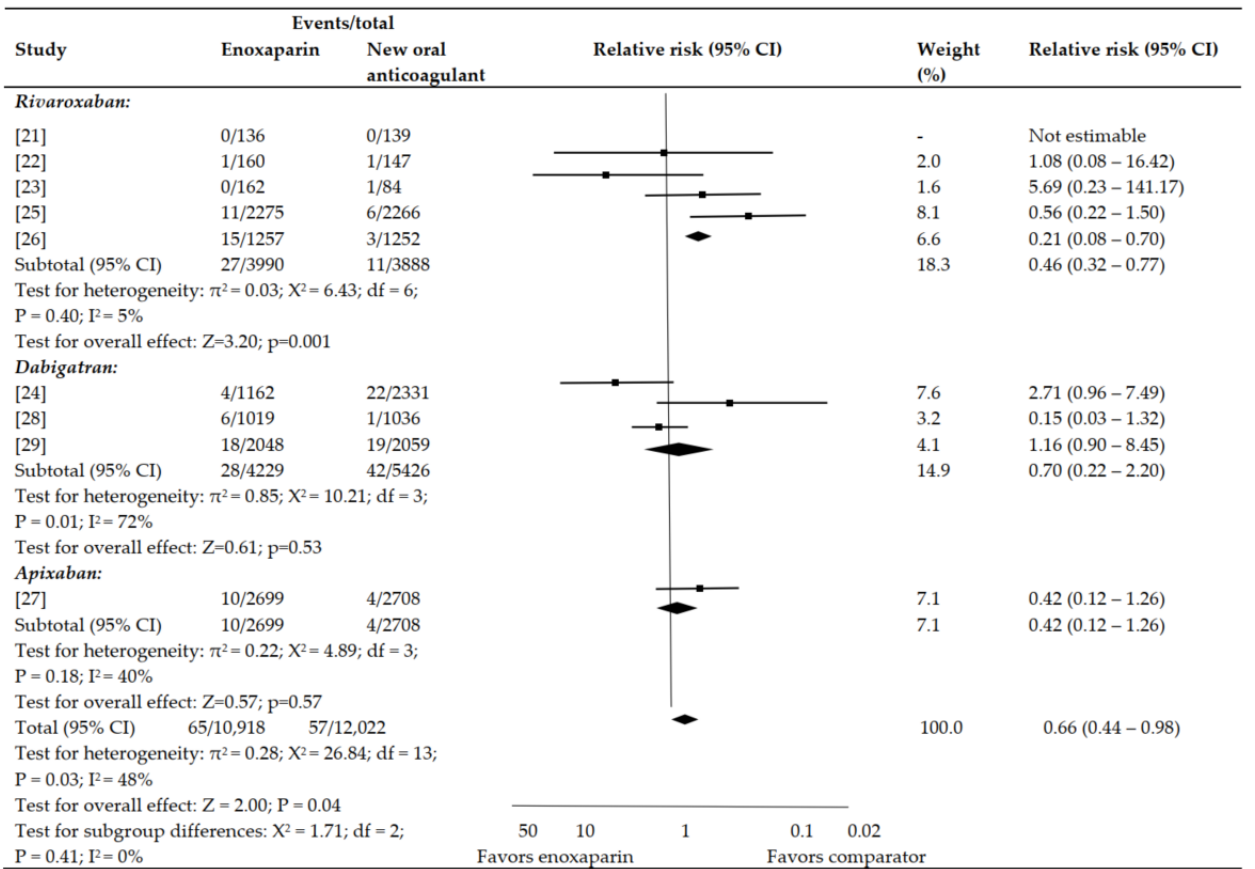
Figure 2. Symptomatic